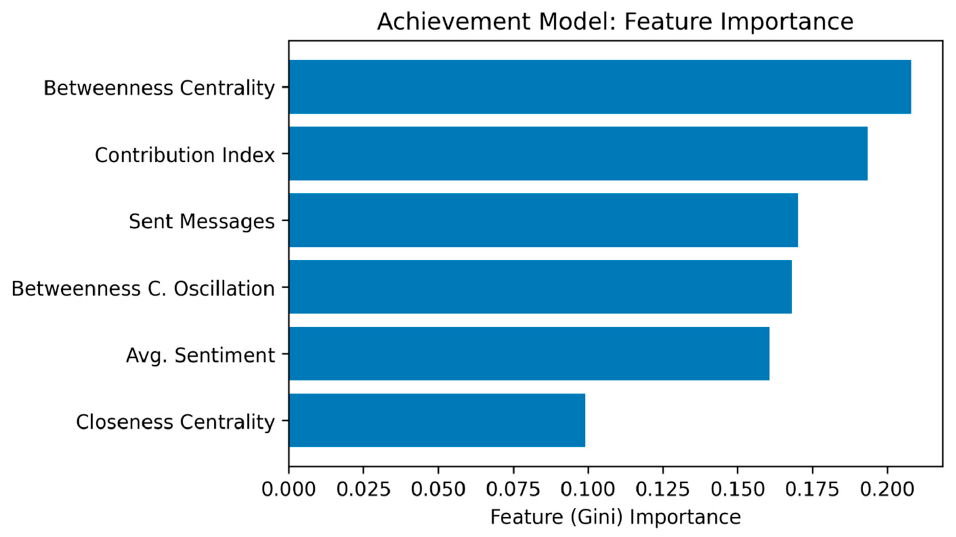
Figure 5. Feature Importance of Power Model.